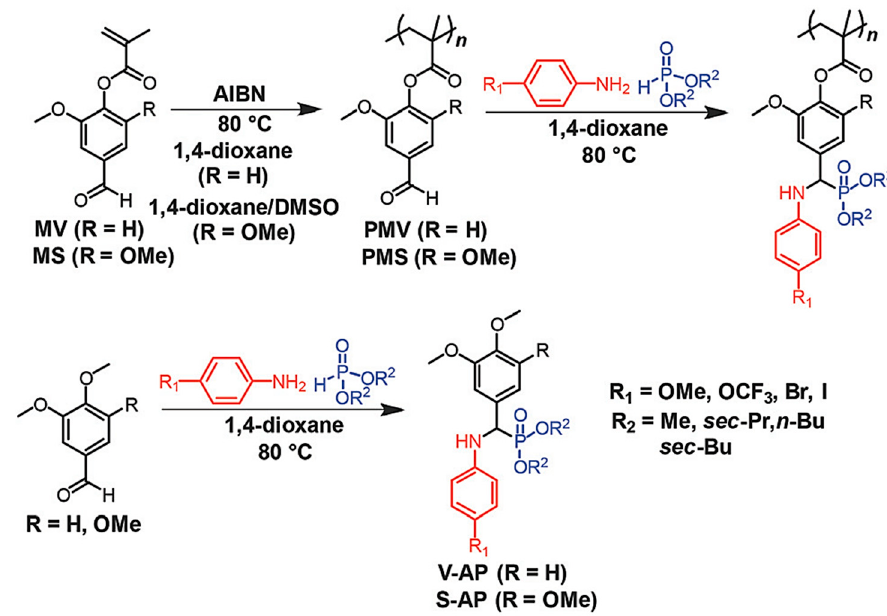
Figure 12. A schematic representation of Kabachnik-Fields post-polymerization modifications of polymethacrylates derived from vanillin and syringaldehyde. Reproduced with permission [50].